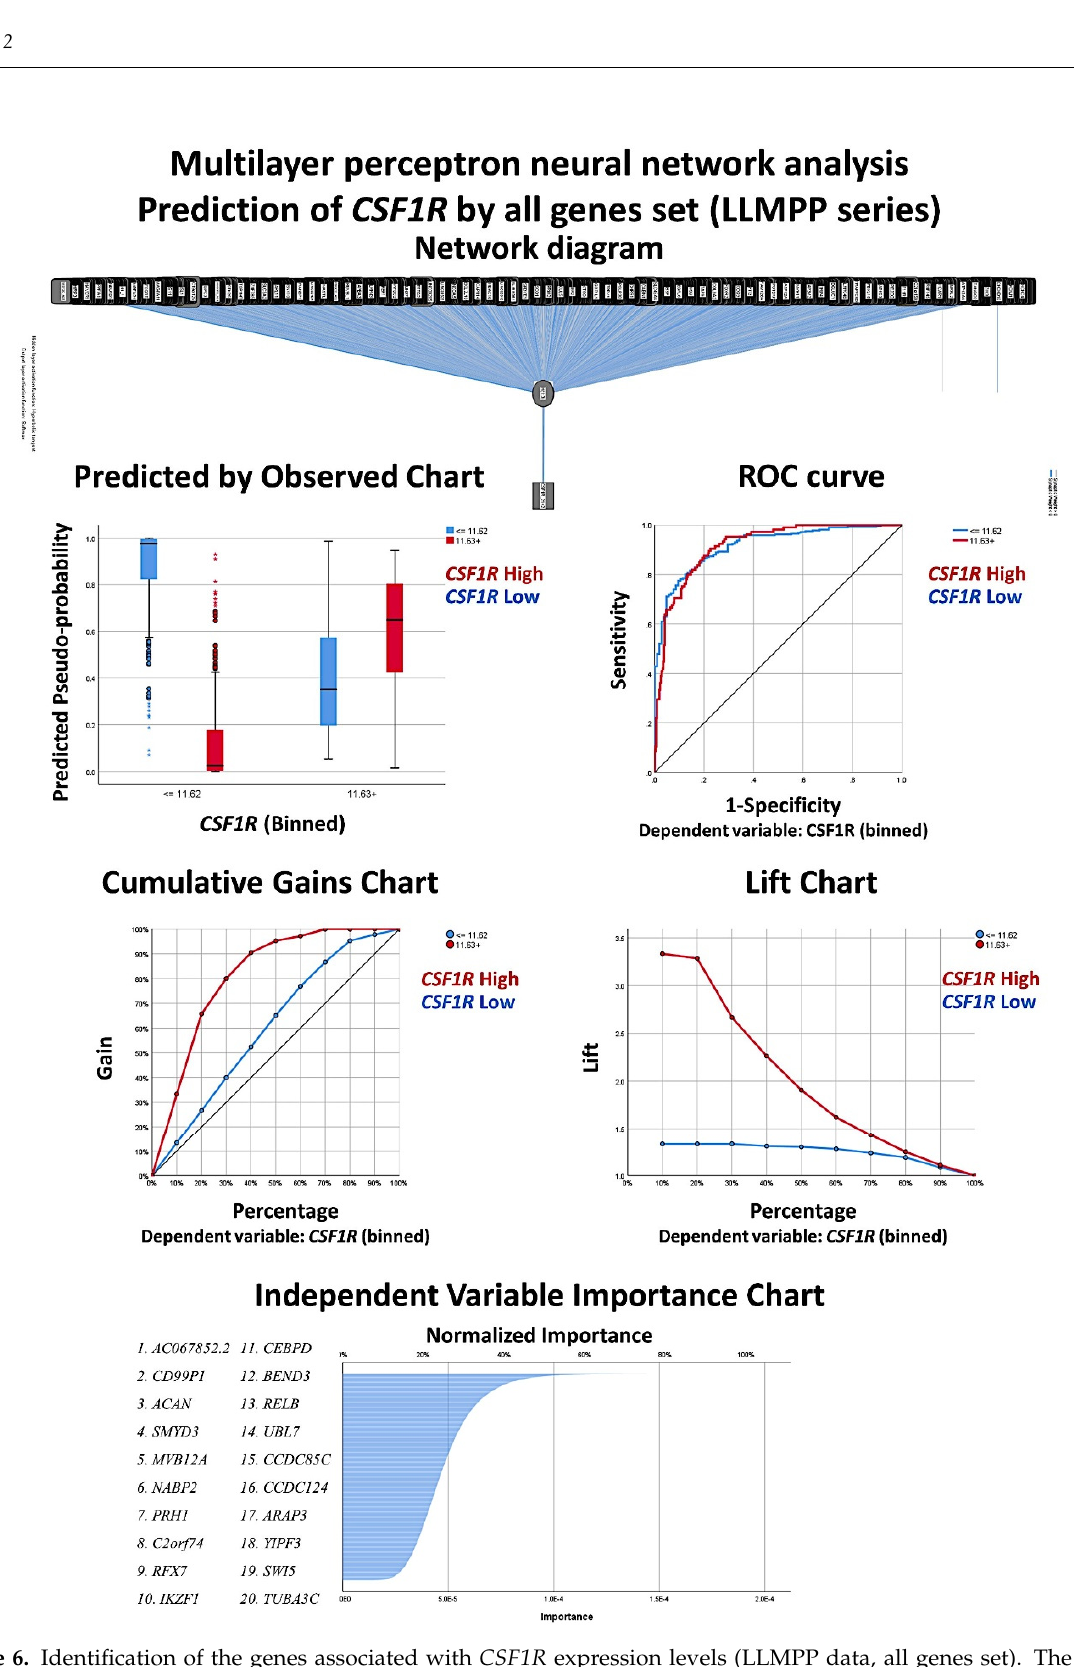
Figure 6. Identification of the genes associated with CSF1R expression levels (LLMPP data, all genes set). The use of artificial intelligence analysis, based on the multilayer perceptron analysis allowed to predict the genes associated with the CSF1R expression (high vs. Low). The 20,683 genes of the array were ranked according to their normalized importance for predicting the CSF1R expression. The neural network performance was good, with an area under the curve of 0.92. CSF1R High, red color. CSF1R Low, blue color.